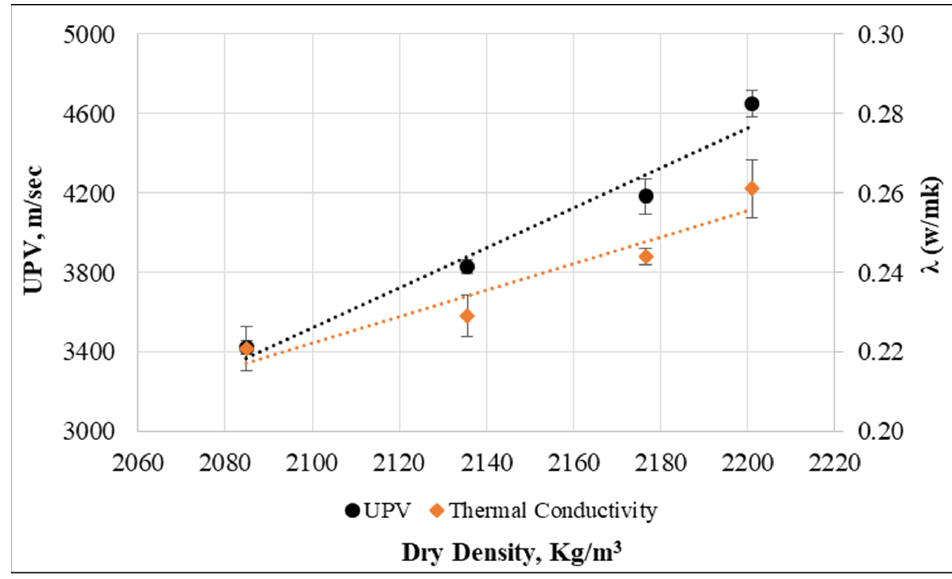
Figure 28. Relationship between UPV, thermal conductivity, and dry density.